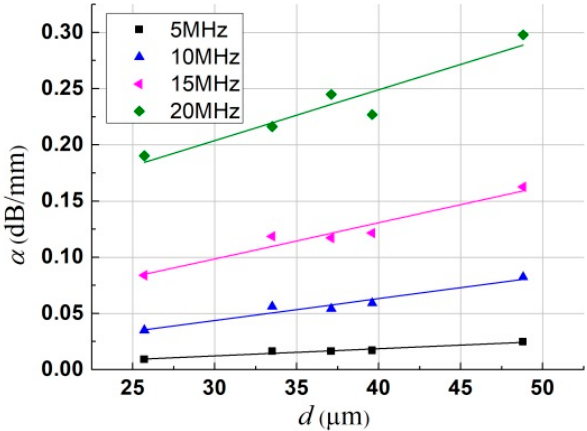
Figure 8. Linear fitting for grain size dependence of attenuation at four given frequencies. (Color online).